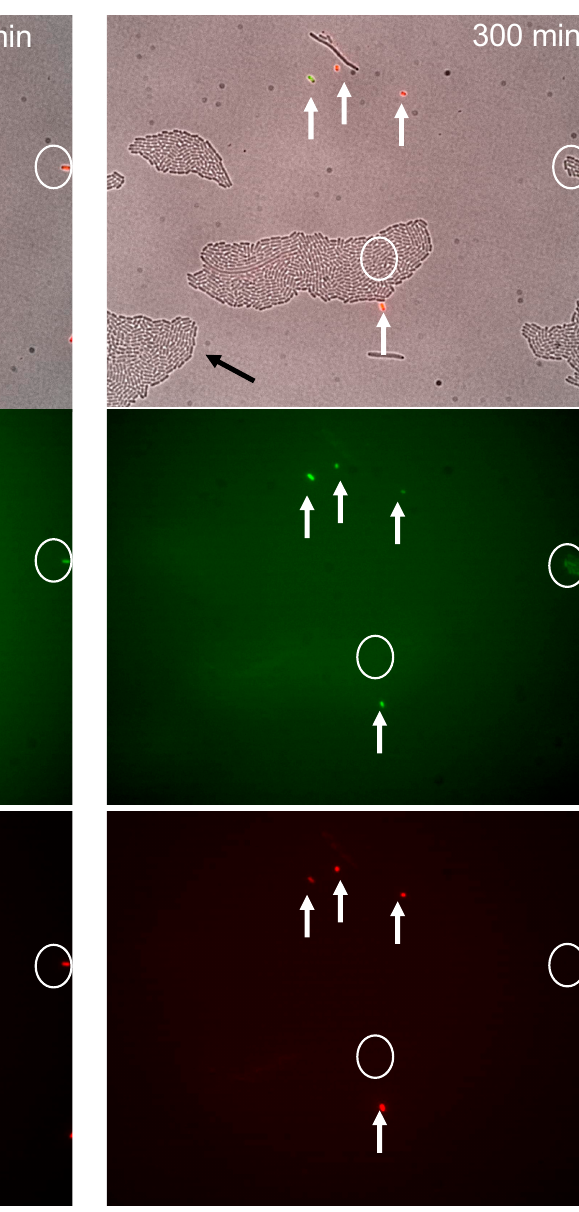
Figure 3. Time lapse microscopy analysis of growth of S. Typhimurium cells that differ in the expression of invasion and flagellar genes. Image from a typical time-lapse microscopy experiment with strain SV8533 ( sipB :: gfp and fliC :: mCherry ) (left panel) and after growth on an agar pad at 37 ° C Figure 300 min (right panel). Bacteria were imaged to detect SPI-1 ( sipB gene) and flagellar ( fliC gene) expression (green and red fluorescence, respectively) and growth (phase contrast, 1 frame/10 min). Flag OFF SPI-1 OFF individual cells are represented as a black arrow, Flag ON SPI-1 ON individual cells as white arrows, and Flag ON SPI-1 OFF and Flag OFF SPI-1 ON cells as white circles.